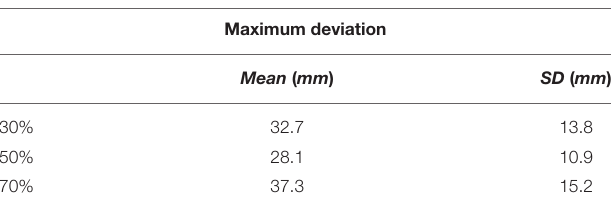
TABLE 3 | Reaching results. Two aruco markers are fixed on the arm, two markers fixed on the forearm, and one fixed on the wrist, as shown in Figure 8